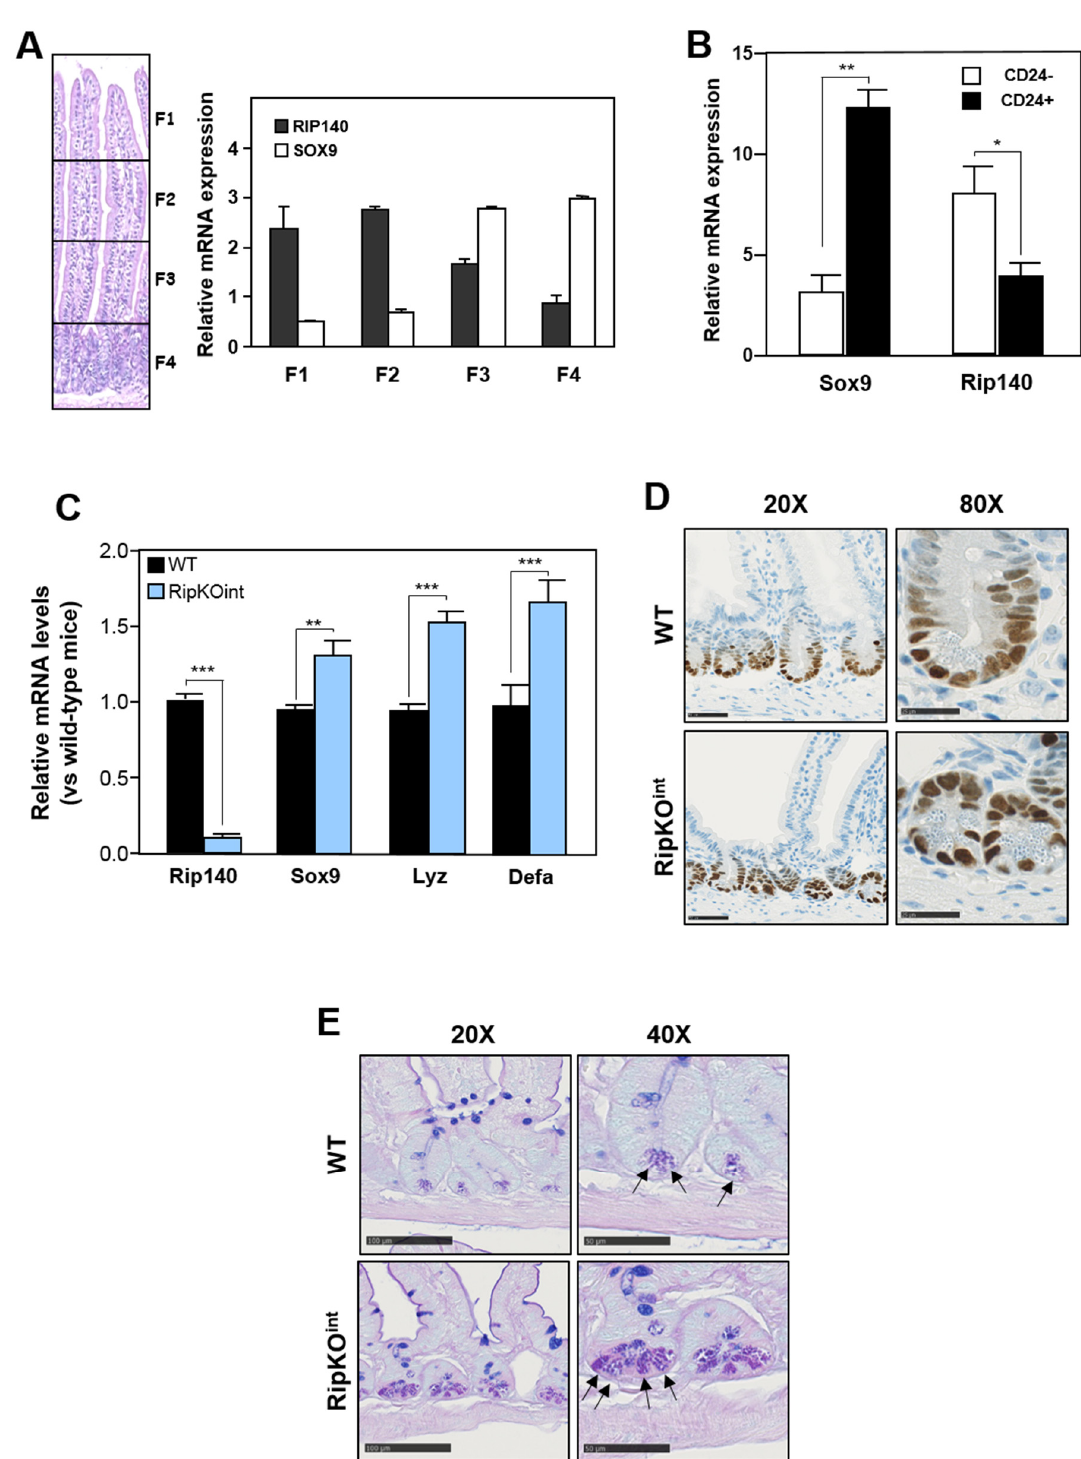
Figure 1. ( A ) RT-qPCR analysis of Rip140 and Sox9 in fractions of the epithelial cells along the villus—crypt axis of wild-type (WT) mouse tissues. The results are expressed in arbitrary units after normalization by RS9 mRNA levels. Values are the means ± SEM of 4 independent experiments. ( B ) Reanalysis of Rip140 and Sox9 mRNA expression from RNA sequencing of Paneth cells (CD24 + cells) and non-Paneth cells provided by Yu et al. [2]. ( C ) RT-qPCR analysis of Rip140, Sox9, Lysozyme (Lyz), and Defensin (Defa) in small intestines of WT and RipKO int mice. ( D ) Immunostaining of Sox9 and ( E ) PAS-BA coloration of WT and RipKO int small intestines. A Student t test was used for statistical analysis: * p < 0.05, ** p < 0.01 and *** p < 0.001.